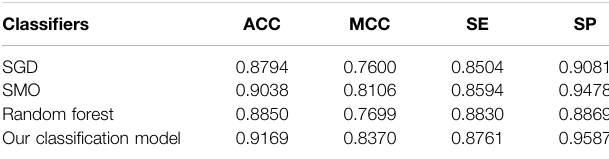
TABLE 2 | Result of different classi fi ers on